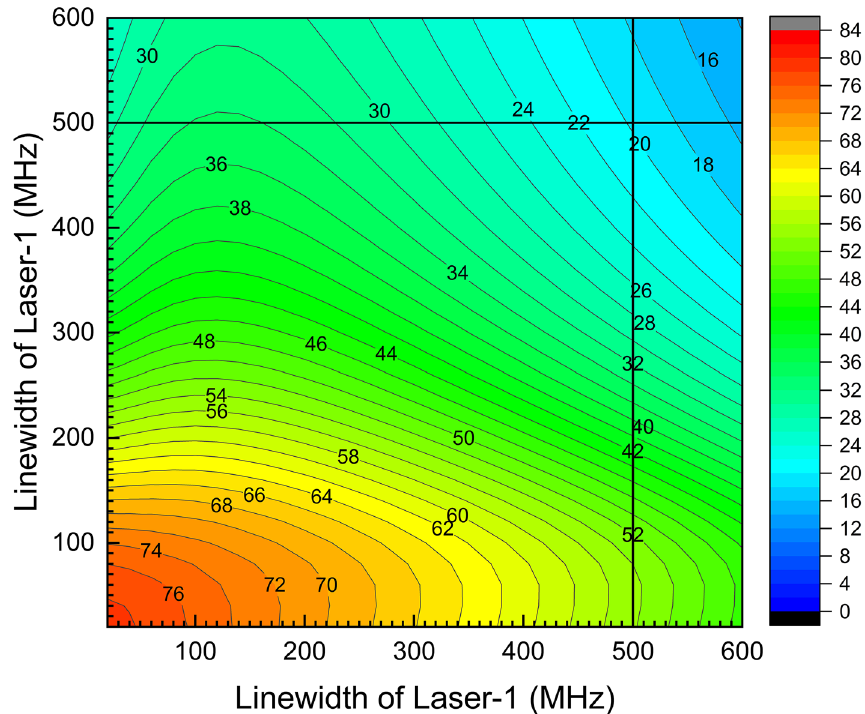
Figure 3. A plot of degree of enrichment of 223 Ra isotope with variation in the bandwidth of excitation lasers. Full angle divergence of the atomic beam is 30°. Peak power densities of the first, second and third excitation lasers are 10, 10, 10,000 W/cm 2 respectively. Atomic number density is 1 × 10 12 atoms/cm 3